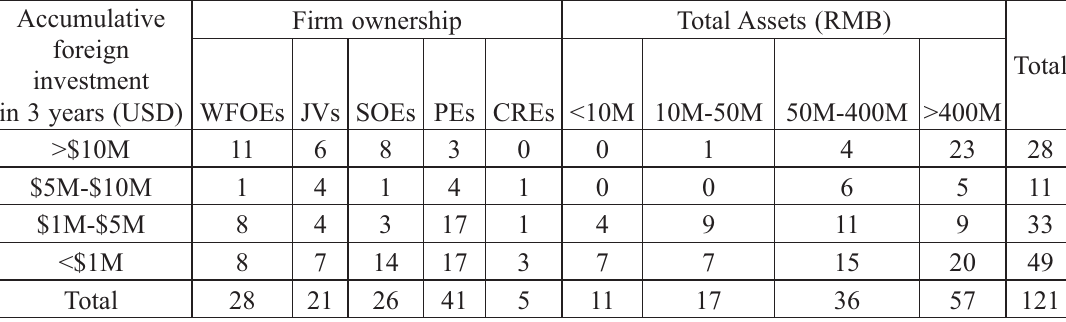
Table 4. Investment scale of outward FDI for the past three